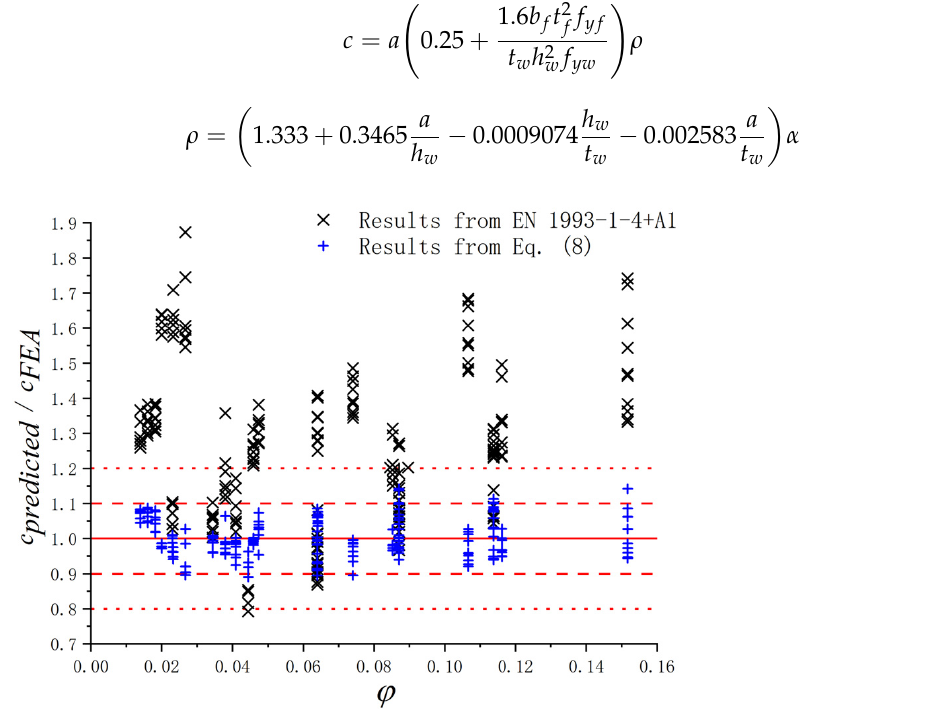
Figure 22. Comparison between the results from FEA, the EN 1993-1-4+A1 design equation for stain- less steel plate girders, and the new modified Equation (8) . stainless steel plate girders, and the new modified Equation